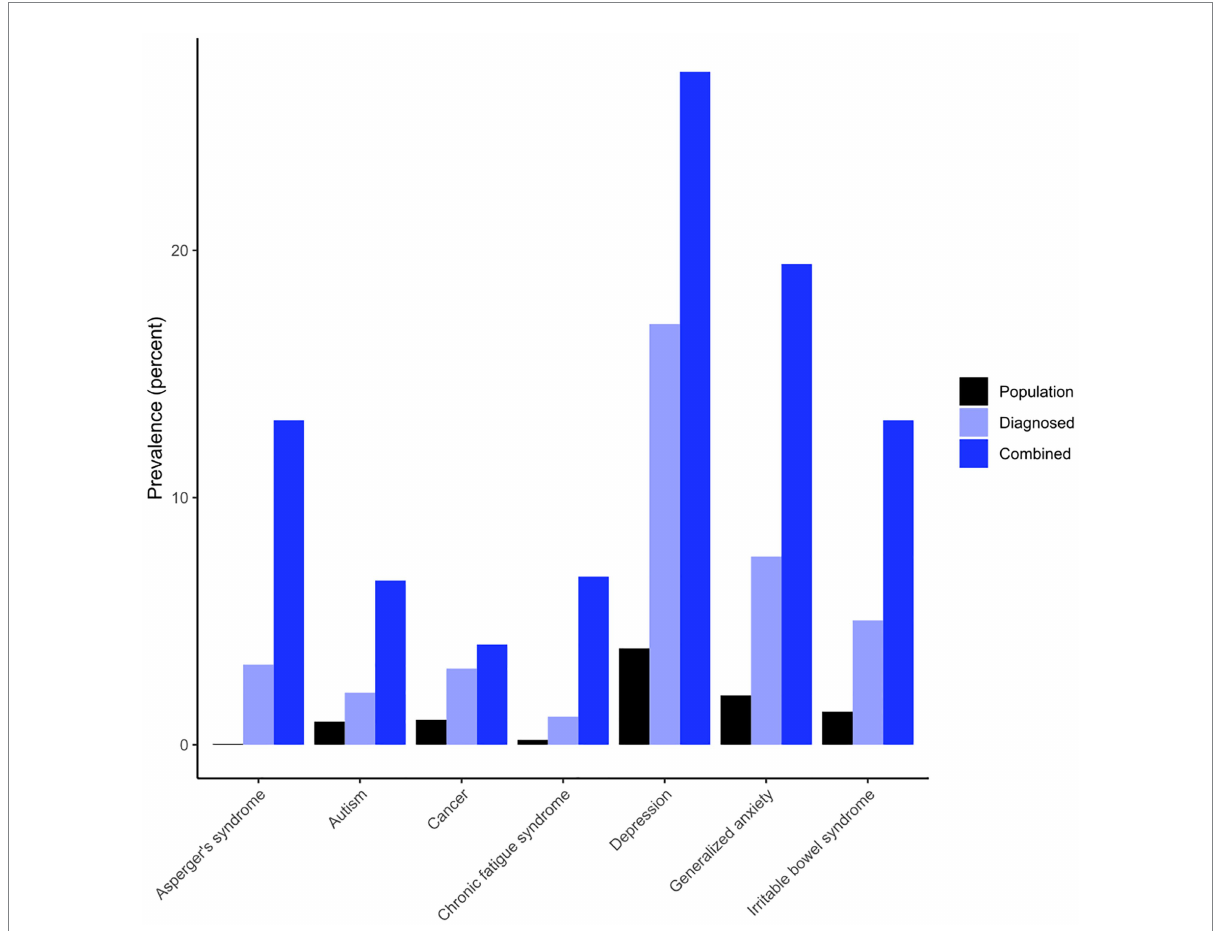
FIGURE 1 Bar chart for all conditions that exhibited elevated sample